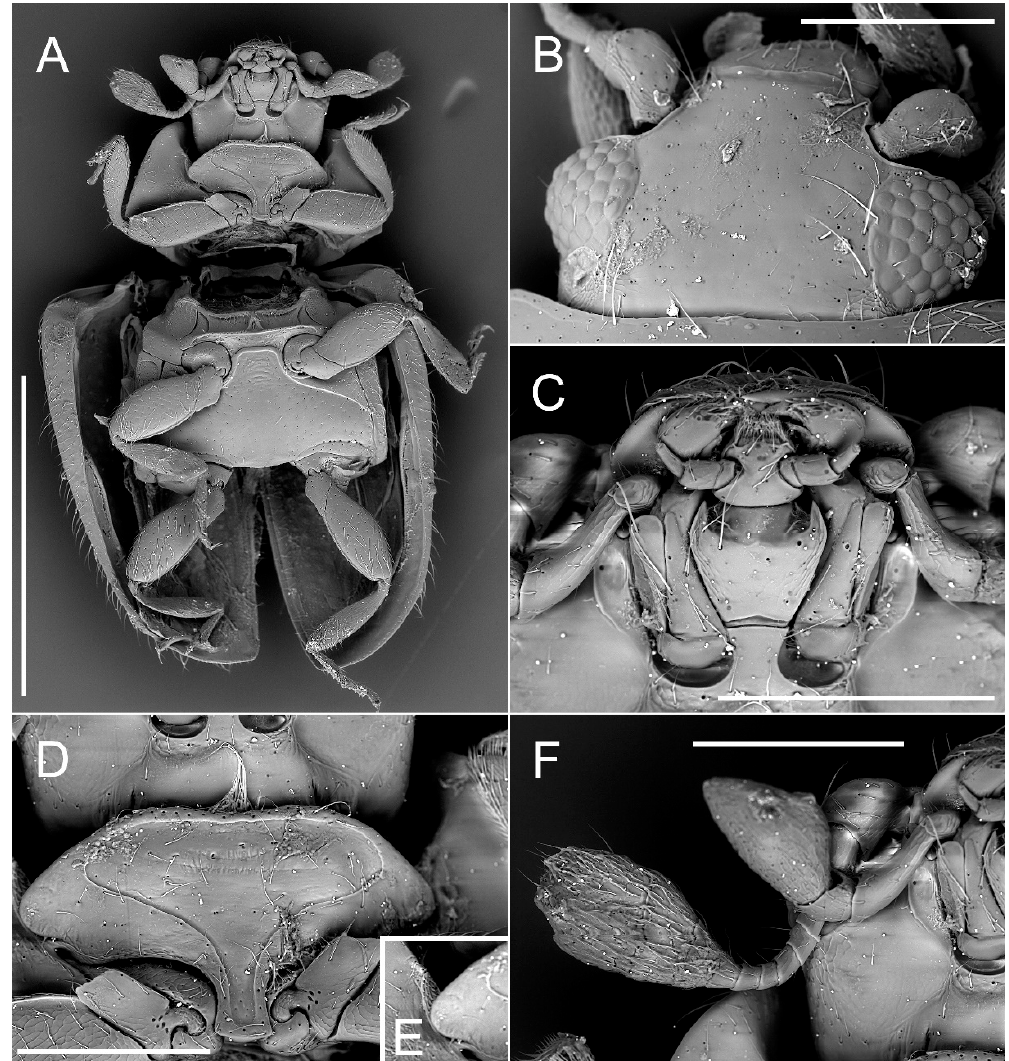
Figure 3. Morphology of Madeirodula atlantica gen. et sp. nov. ( A ) habitus, ventral. ( B ) head, dorsal. ( C ) mouthparts, ventral. ( D ) gular region of head and prosternum, ( E ) antero-median part of hypomeron with area of glandular structures. ( F ) maxillary palp and antenna. Scale bars: 1 mm ( A ); 0.2 mm ( B – F ). Genus: Madeirodula gen. nov. (Figures